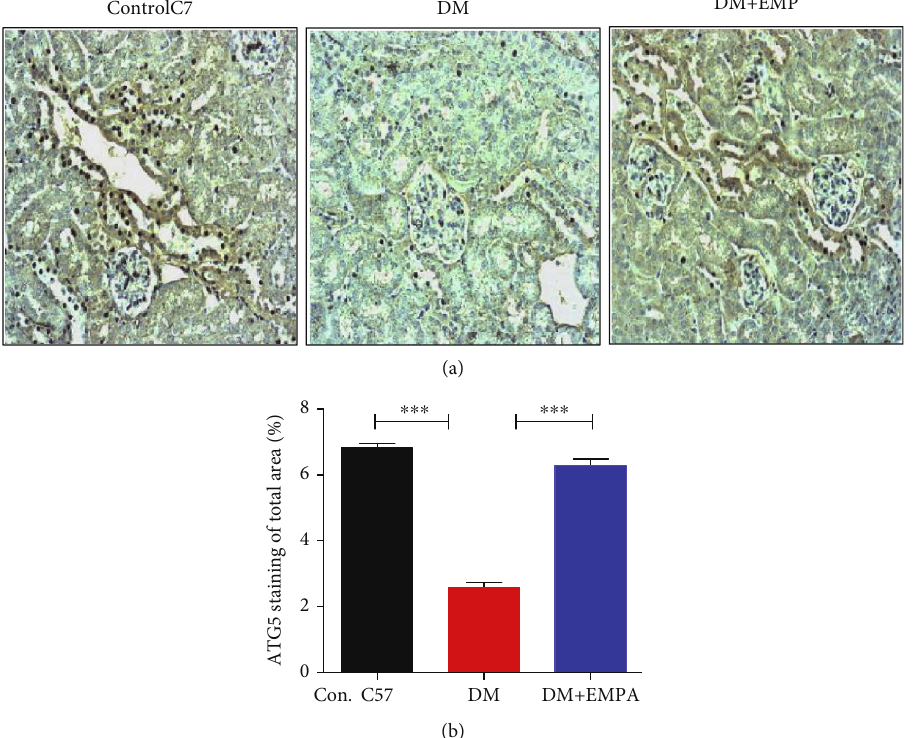
Figure 4: (a) Representative IHC staining of ATG5 in mice renal sections (magni fi cation × 20). (b) Quanti fi cation of total renal ATG5 expression in IHC staining: renal ATG5 was signi fi cantly decreased in DM mice compared with C57/Bl mice. A signi fi cant increase in ATG5 levels was observed in DM+EMPA mice compared with DM